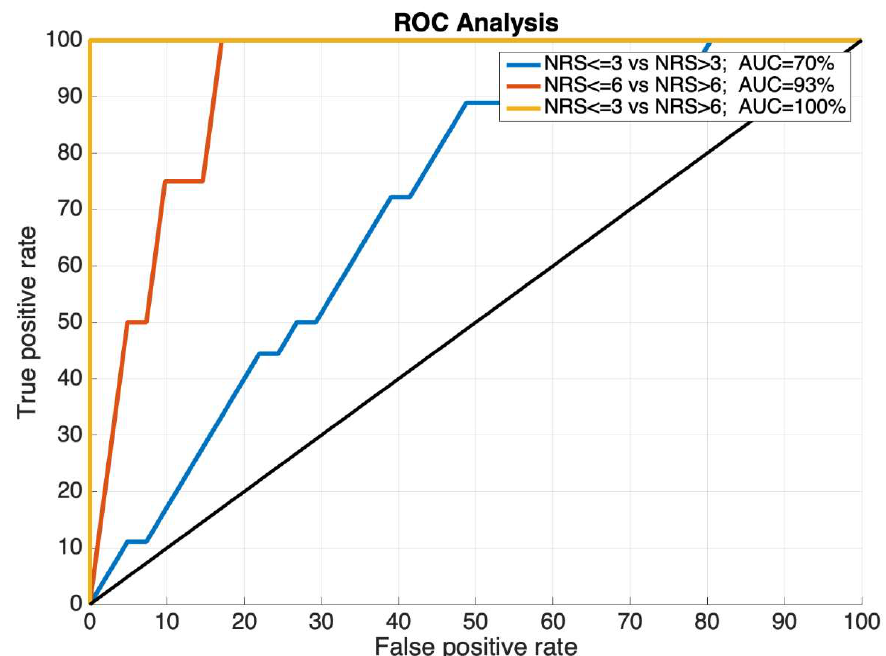
Figure 5. Recovery period receiver operating curves for the numeric rating scale (NRS) ≤ 3 and NRS > 3 (blue line, AUC = 70%); NRS ≤ 6 and NRS > 6 (orange line, AUC = 93%); and NRS ≤ 3 and NRS > 6 (yellow line, AUC = 100%). AUC values, used as a performance indicator, were excellent (AUC > 90%).